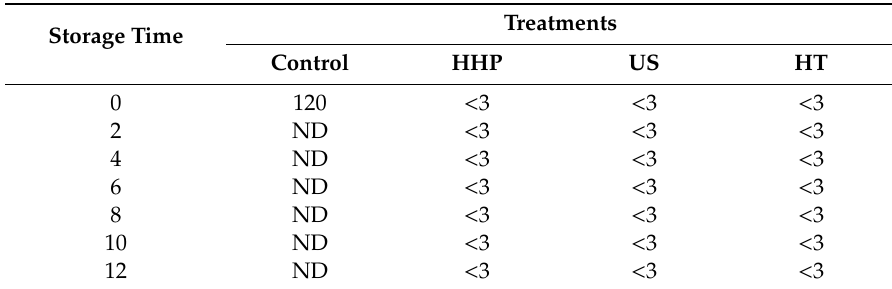
Table 1. Variations of coliforms (MPN / 100 mL) in juice blends treated by HHP, US, and HT after 12 days of storage at 4 ◦ C. Treatments Storage Time Control